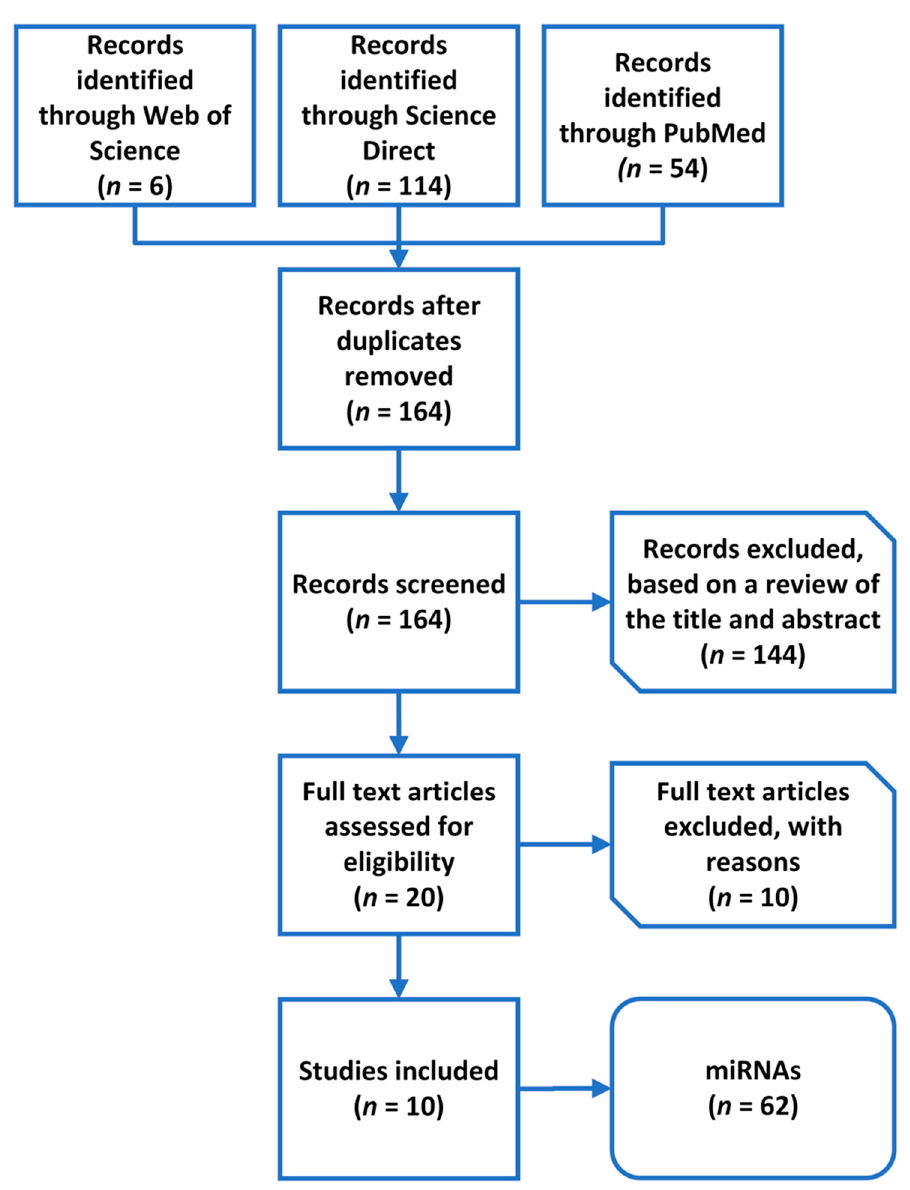
Figure 2. A flowchart of the literature review process and microRNA (miRNA) selection. After removing duplicates, a total of 62 miRNAs associated with PTH were extracted from the 10 selected studies (Tables 1 and